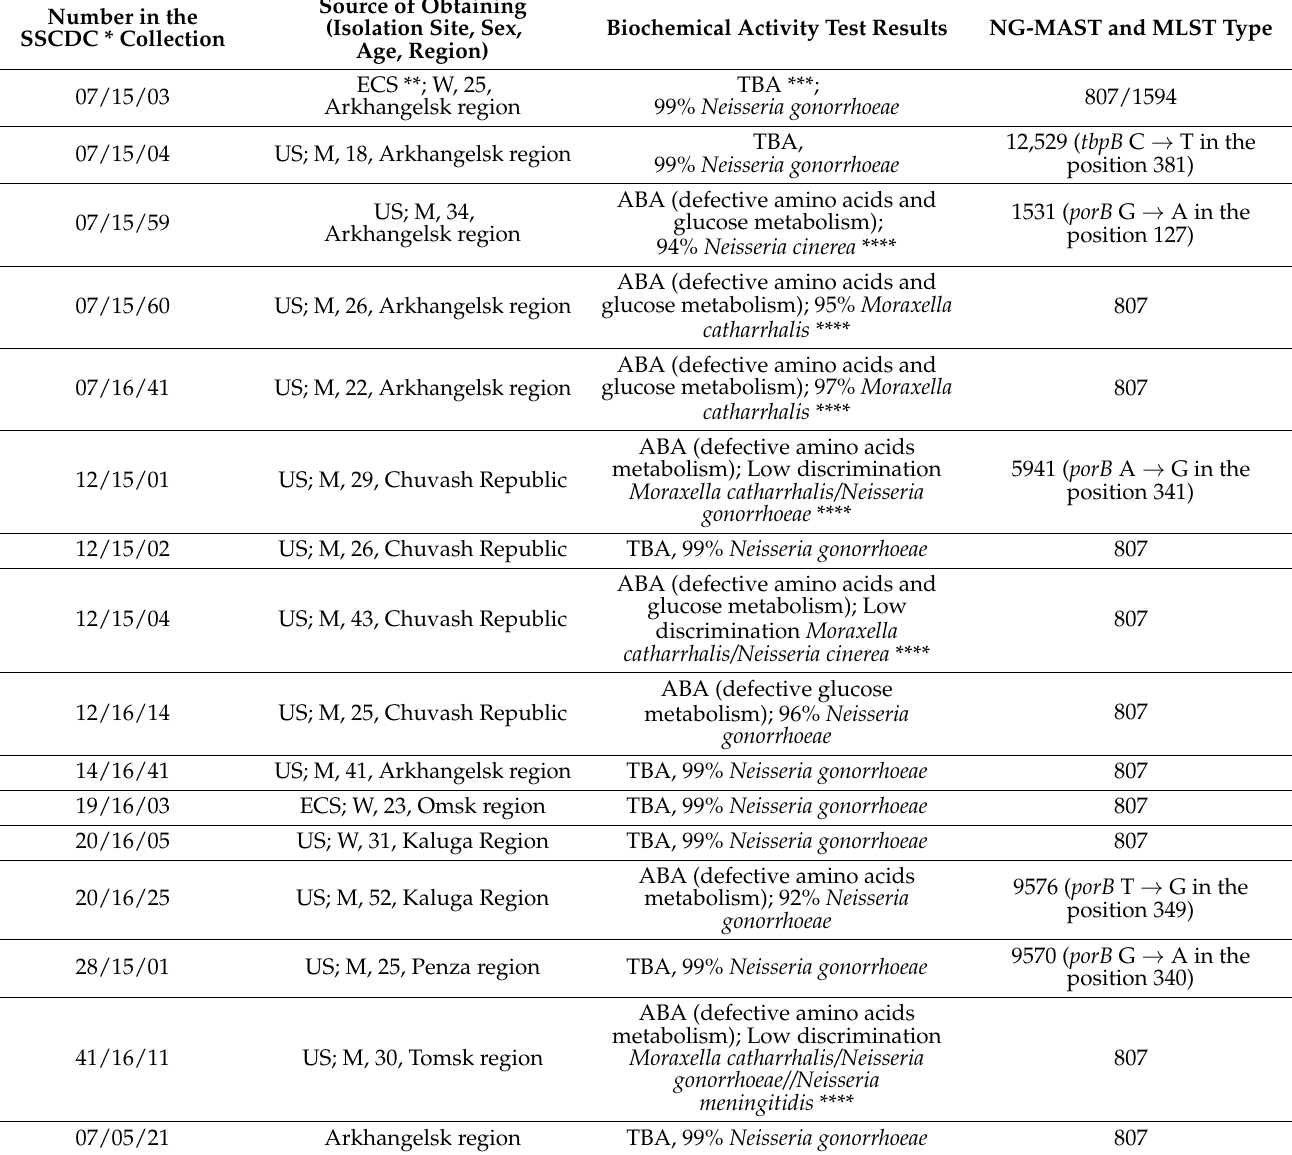
Table 1. Russian clinical isolates of N. gonorrhoeae included in the